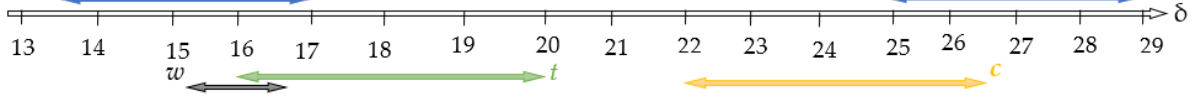
Figure 4. Approximate δ -values (MPa 0.5 ) of SC-CO 2 (top-left), ethanol (top-right), cannabinoids (c), terpenes (t), and waxes (w). Adapted from King J.W. [33], reprint permission had been obtained from Elsevier (Copyright 2019).